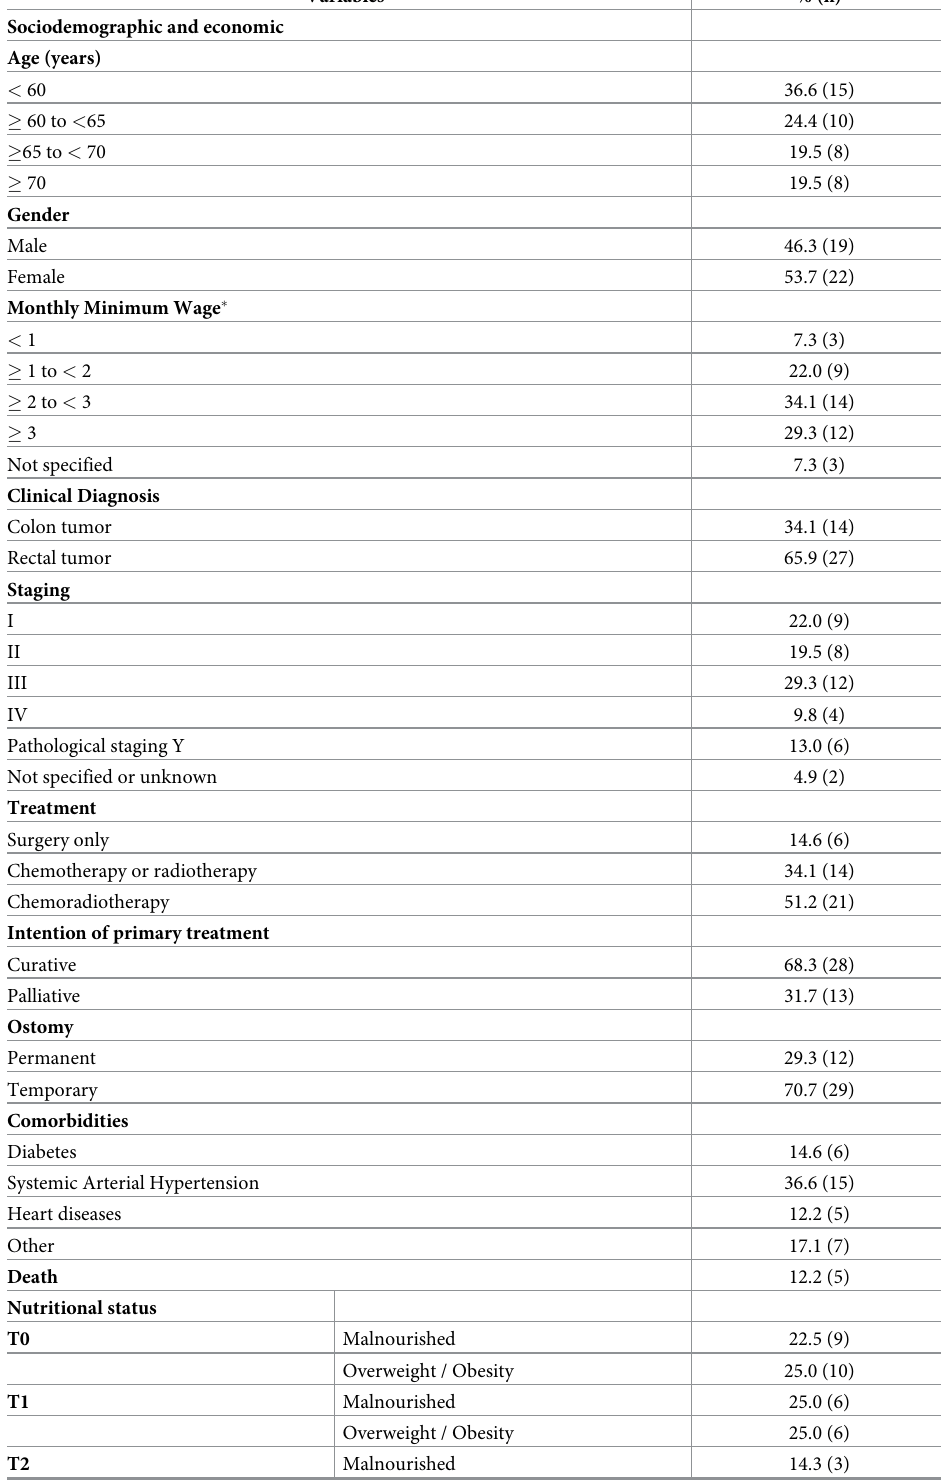
Table 1. Sociodemographic and clinical data of patients with colostomy for colorectal cancer (n =